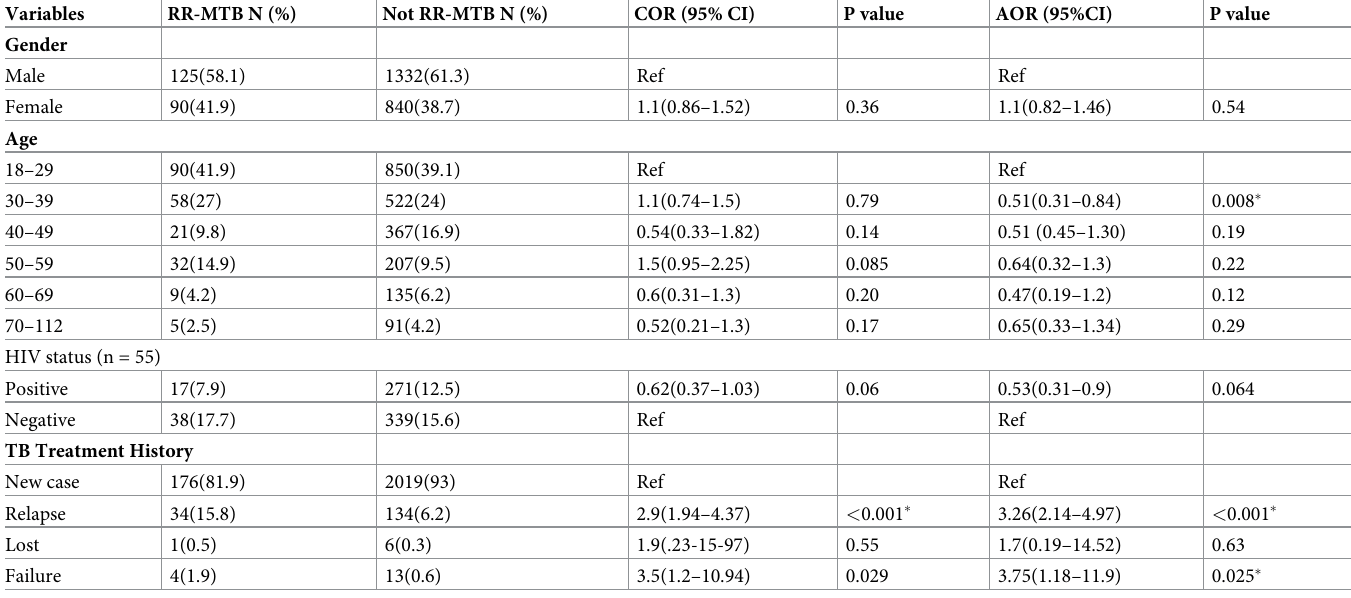
Table 3. Frequency of RR-MTB among adult TB patients by sex, age, treatment history and HIV status in Eastern, Mekelle and Southern Zones of Tigray, Ethiopia, 2016–2019 (N = 2,387).